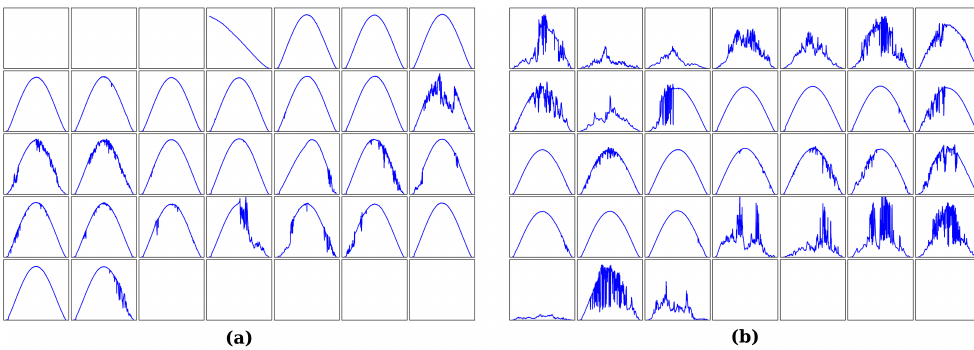
Figure 4. Daily GHI plot calendars of two different months: ( a ) June 2014 and ( b ) March